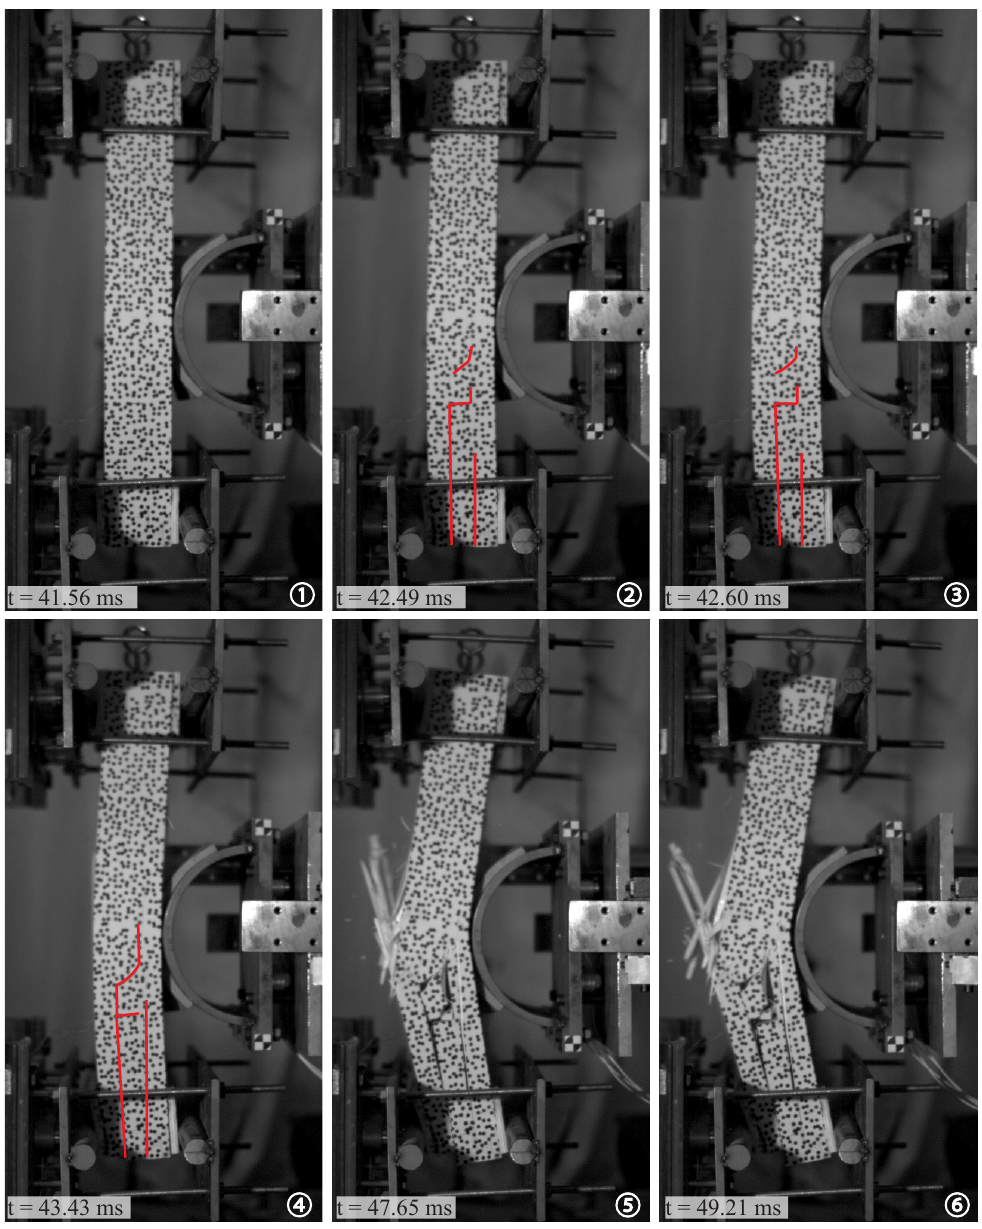
Figure 26. CLT3-5 Damage progression.